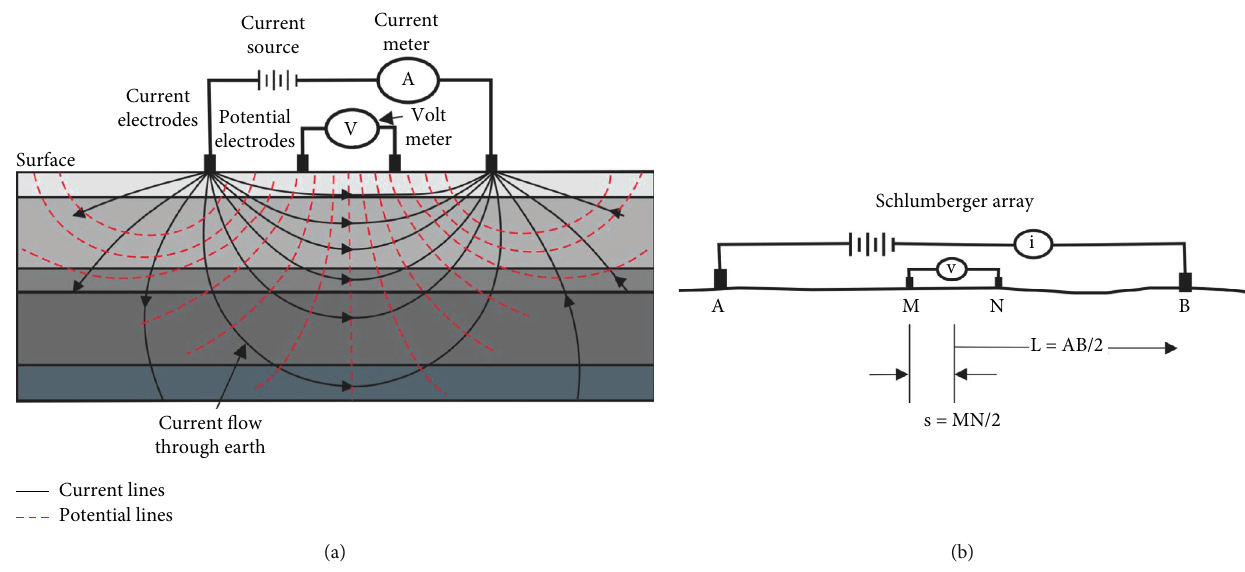
Figure 4: (a) Schematic illustration of the basic measurements using electrical resistivity method. Solid black lines represent current fl ow through layered subsurface structure. Dashed red line contours electrical potential, and (b) the Schlumberger electrode con fi guration is utilized for this study. AB represents spacing between current electrodes, and MN represents spacing between potential electrodes (modi fi ed after [29 – 31]). Table 1: Resistivity ranges associated with di ff erent lithological units across the study area (modi fi ed after Yadav et al.